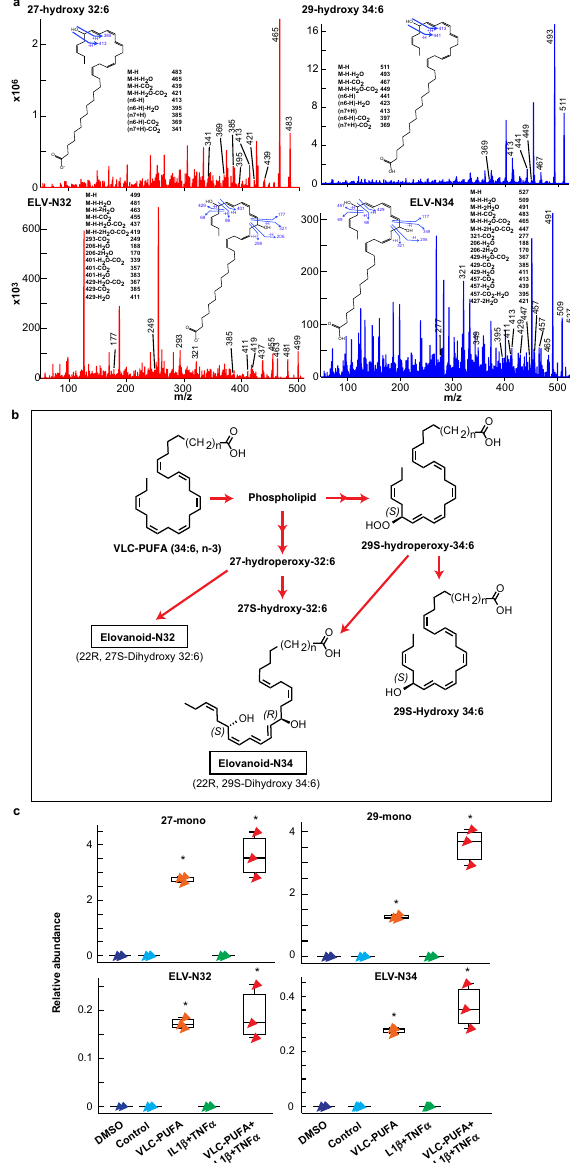
Figure 2. Fate of VLC-PUFAs (C32:6 and C34:6, 2 μM each) added to human primary alveolar cells cultures towards ELV synthesis. ( a ) 27-monohydroxy-32:6, 29-monohydroxy-34:6, and ELVs are formed. Full fragmentation of 27-monohydroxy-32:6 and 29-monohydroxy-34:6 show matches to their theoretical peaks (top panels). The inserts depict the structures of 27-monohydroxy-32:6 and 29-monohydroxy-34:6 along with the product ions as they are cleaved at a given bond. The complete structures of ELV-N32 and ELV-N34 were confirmed to be: ELV-N32: (14 Z ,17 Z ,20 R ,21 E ,23 E ,25 Z ,27 S ,29 Z )-20,27-dihydroxydo-triaconta- 14,17,21,23,25,29-hexaenoic acid; ELV-N34: (16 Z ,19 Z ,22 R ,23 E ,25 E ,27 Z ,29 S ,31 Z )-22,29-dihydroxytetra- triaconta-16,19,23,25,27, 31-hexaenoic acid (bottom panels). ( b ) Synthesis Pathways for ELV-N32 and ELV-N34 from VLC-PUFAs 34:6, n-3 . (c ) Relative abundance of the elovanoids N32 and N34 (bottom panels) and their intermediates 27 mono-hydroxy and 29 mon-hydroxy (top panels) when the alveolar cells are exposed to the precursors VLC-PUFAs: 32:6 and 34:6 in the presence or absence of 10 ng/ml IL1β and 10 ng/ml TNFα for 24 h. The plot shows the box upper limit 3rd Quartile, bottom side 1st quartile, middle line: the median and the whiskers denote the maximum and minimum observations. * P < 0.05 in t-test comparisons with the respective